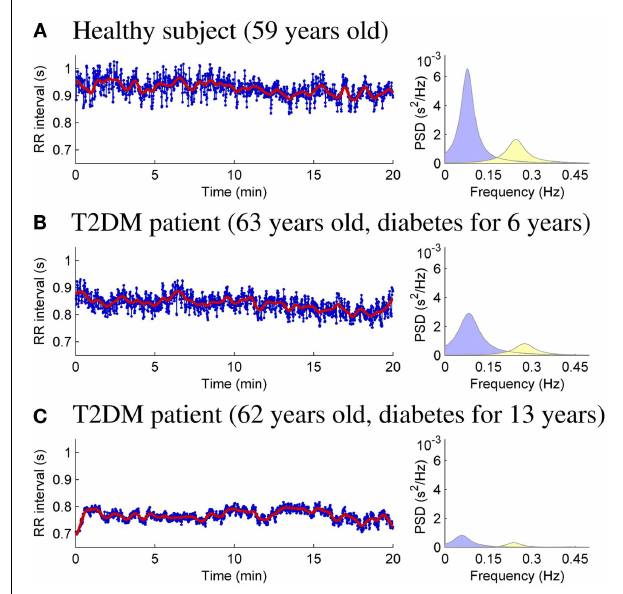
FIGURE 1 | RR interval time series (bold line showing the removed trend) andAR spectrum estimates for healthy control subject (A), T2DM patient diagnosed 6years prior to measurement (B), andT2DM patient diagnosed 13years prior to measurement (C) .